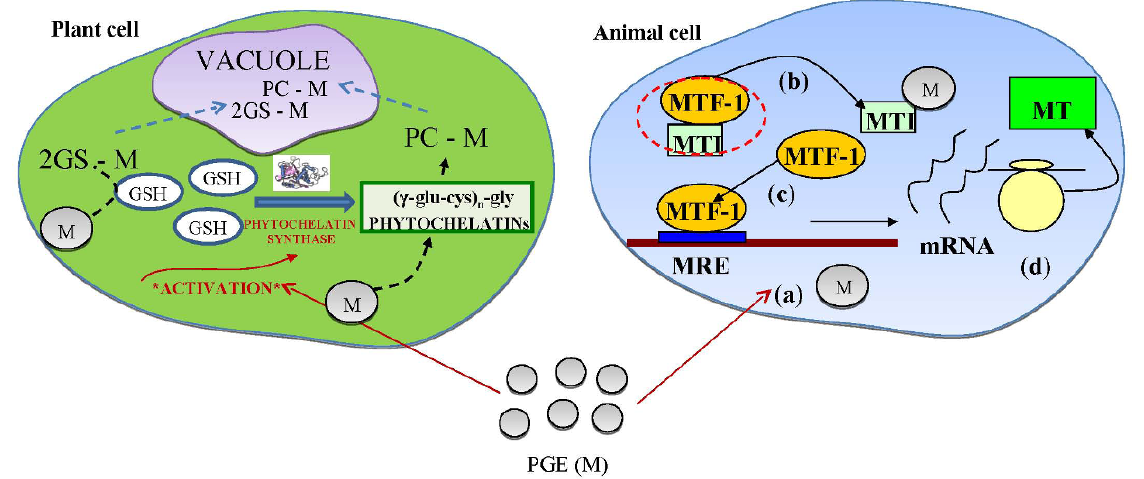
Figure 5. Plant cell . Glutathione serves as a precursor of phytochelatins, which are composed of two or more repeating gamma-glutamylcysteine units with a terminal glycine residue; (gamma-glutamylcysteine) -gly, where n = 2 to 11. The enzyme responsible for the synthesis of n these peptides is known as phytochelatin synthase (glutathione gamma-glutamylcysteinyltransferase or gamma-glutamylcysteine dipeptidyl transpeptidase), which is a constitutive enzyme that is activated by cadmium and other metal ions. Animal cell . Metal ions enter through a cytoplasmic membrane using ionic channels or special transporters (a). After the entering the cytoplasm, the ions interact with complex of metal-regulatory transcription factor-1 (MTF-1) and metal synthesis inhibitor (MTI) (b). The ions bind to MTI. Due to the binding of the ions to MTI, MTF-1 is released and can bind to a regulatory sequence of DNA called metal responsive element (MRE) (c). Further, the gene responsible for synthesis of metallothioneins is transcribed. The synthesized mRNA molecule is translated into MT (d). MT binds to the heavy metal